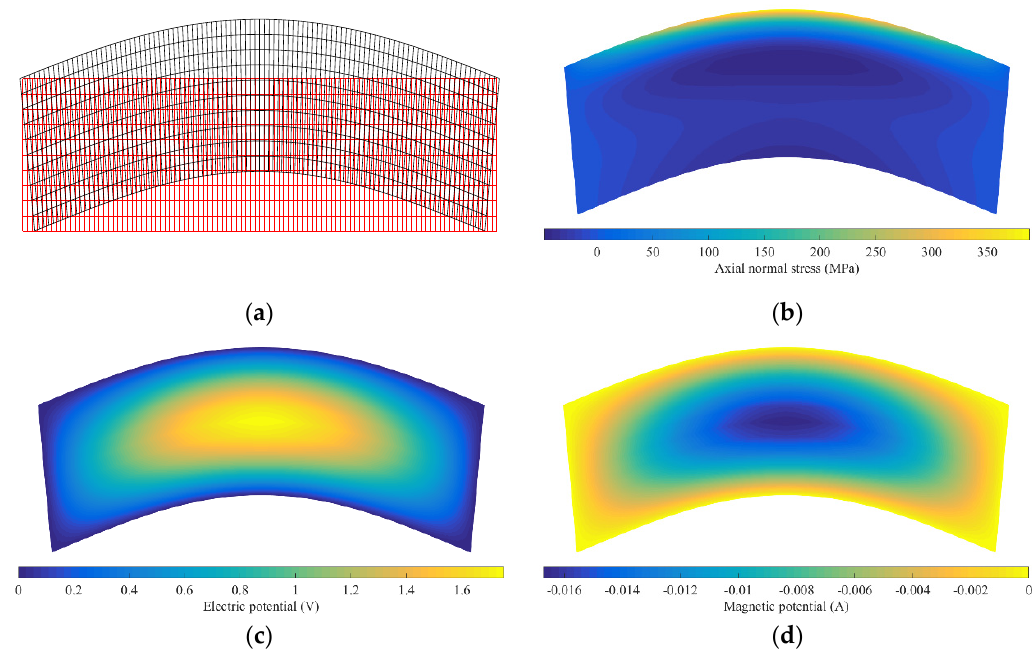
Figure 3. Distribution of ( a ) deformation, ( b ) axial normal stress, ( c ) electric potential, and ( d ) magnetic potential (Gradient index n = 5).